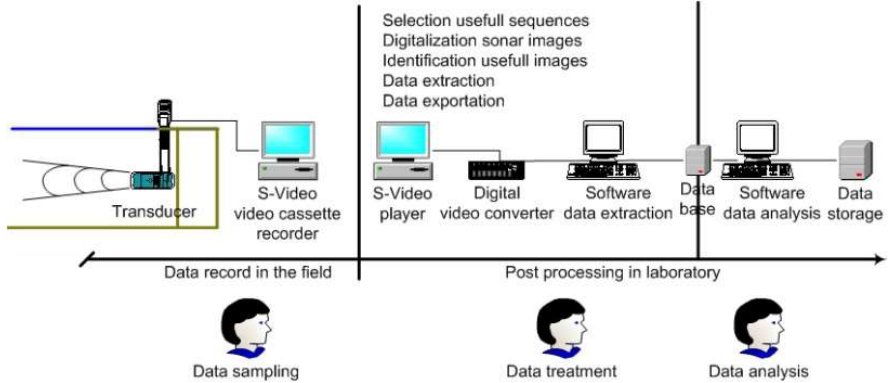
Figure A1. Scheme representing the sonar data collection, their treatment, which include several steps (selection of sonar sequence, digitalization, identification of echo traces on sonar images, data extraction and then exportation for final analysis on ad hoc software), and their analysis to obtain the swimming speed measurements.